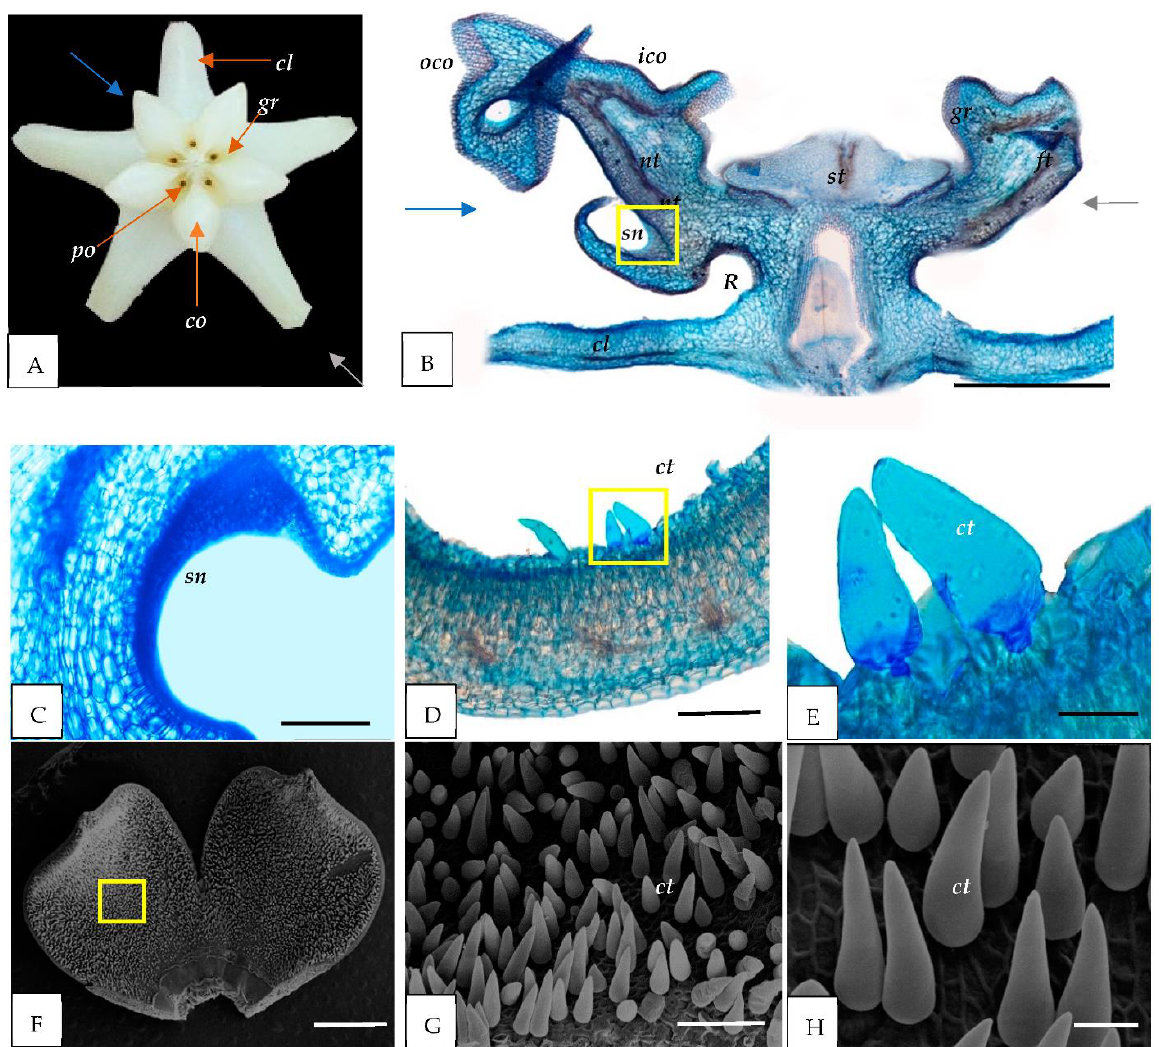
Figure 1. Anatomical and micromorphological structure of the H. cagayanensis flower. ( A ) Flower of H. cagayanensis (front view) with five corolla petals ( cl ), five corona lobes ( co ) with inner ( ico ) and outer ( oco ), and five pollinia ( po ) and five guide rails ( gr ) in between each corona lobe. ( B – E ) LM images. ( B ) The longitudinal section of flower cut in a plane indicated by gray and blue arrows in ( A ); ( C ) secondary nectaries ( sn ) in the corona lobe ( co ); and ( D , E ) cross-sections of corolla petals with unicellular conical trichomes ( ct ) (yellow square). ( F – H ) SEM image of the petals ( cl ); ( G , H ) enlargement in ( F ) (yellow square) indicate the presence of ct . cl = corolla; co = corona; ft = filament tube; gr = guide rail; sn = secondary nectaries; po = pollinia R = nectar pool; nt = nectar tube; st = style head. Scale: ( B ) = 1000 µm; ( C – E , H ) = 200 µm; ( F ) = 1 mm; ( G ) =100 µm.